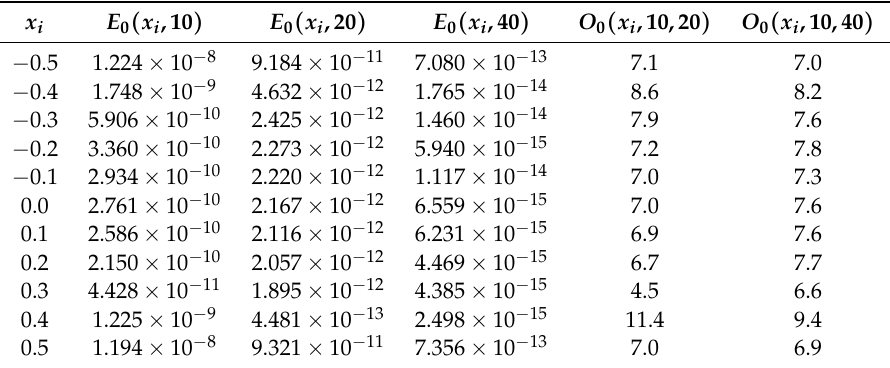
Table 8. The absolute errors of the function values of y 2 at the knots and the numerical convergence orders.